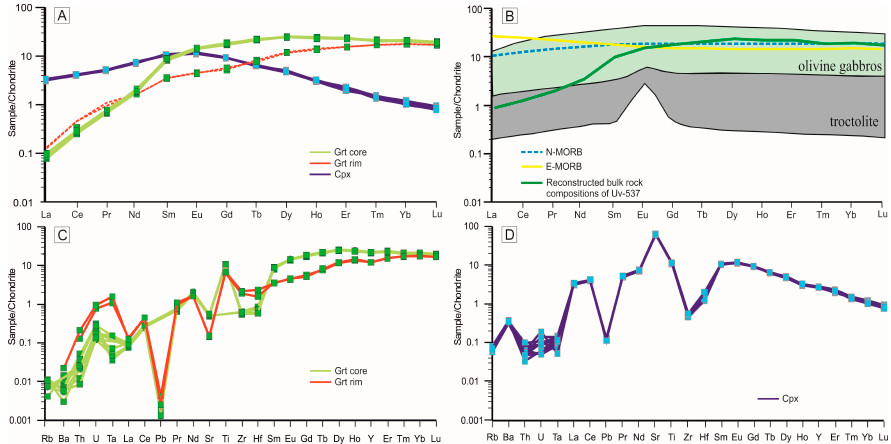
Figure 8. Chondrite-normalized rare earth elements (REE) [93] ( A ) and extended trace element patterns ( C , D ) of clinopyroxene and garnet (core and rim) from Uv-537 eclogite. Panel ( B ) shows bulk rock composition reconstructed. The average N-MORB and E-MORB REE compositions [94] are shown for reference as well as the range of troctolite compositions from Pito Deep, Pacific ridge [95] and the compositional field of olivine gabbros from the MARK region, mid- Atlantic ridge